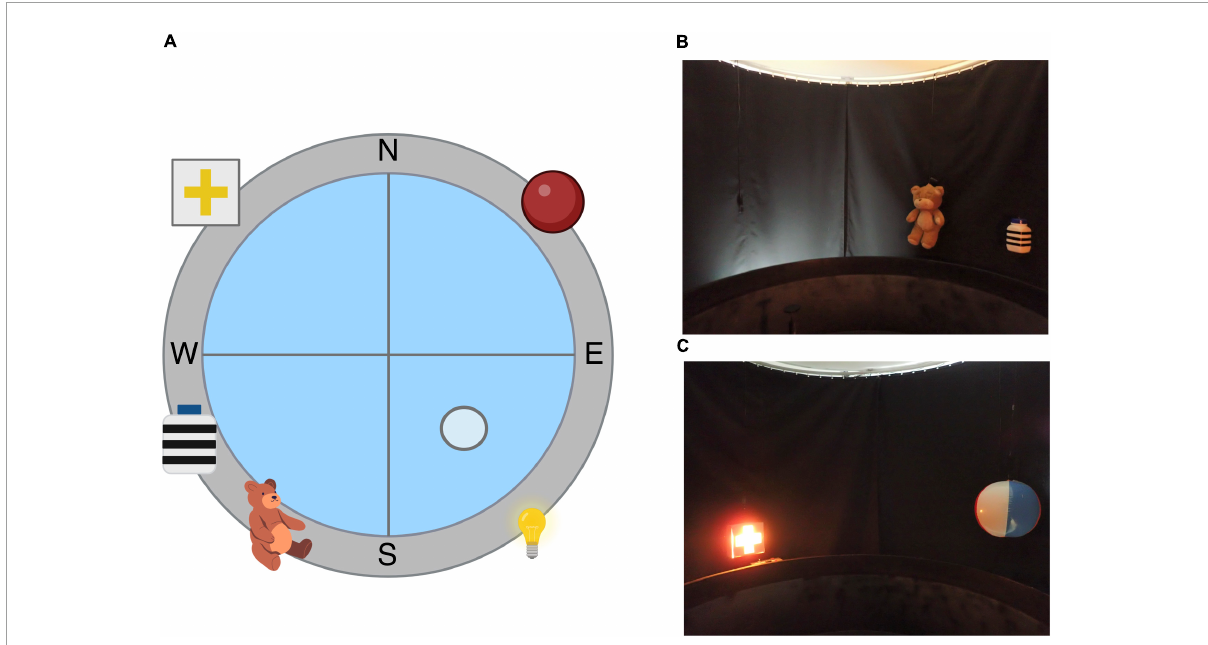
FIGURE5 Morris Water Maze apparatus. (A) Illustration depicting the spatial Morris Water Maze configuration used in our lab. (B) Picture of the objects used in the South-east (SE) and South-west (SW) quadrants. (C) Picture of the objects used in the North-west (NW) and North-east (NE)